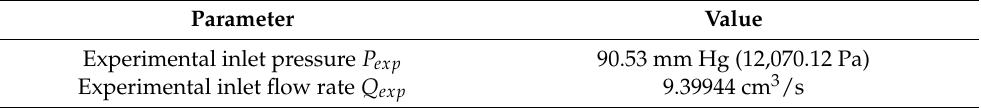
Figure 5. Geometry of inlet and outlets of the CHN03 model. Table 2. Experimentally obtained input parameters for simulation of CT209.